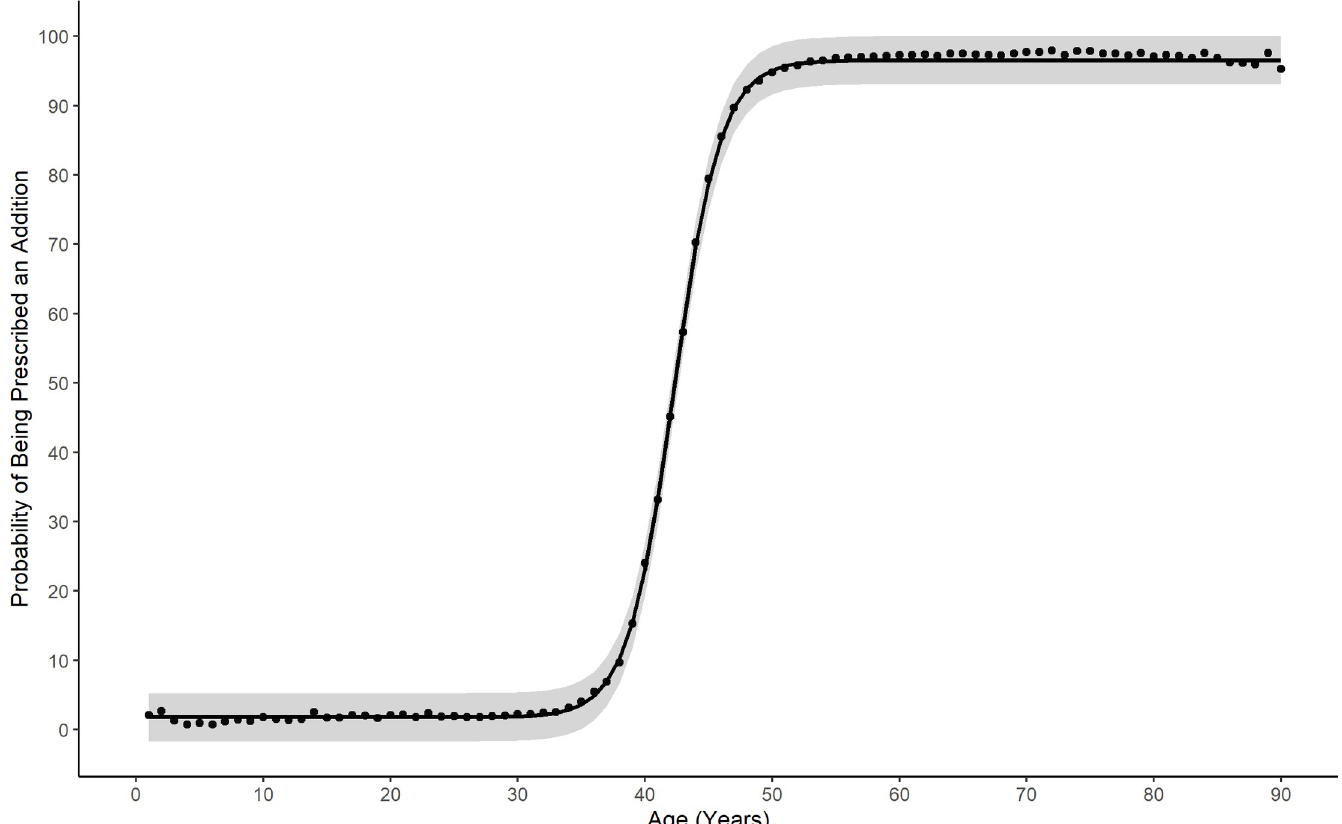
Fig 5. Likelihood of needing a reading addition for EMR patients at different ages with 95% prediction